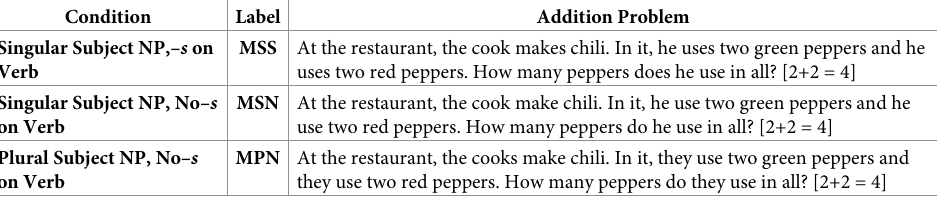
Table 9. Example auditory stimuli for the mathematical reasoning experiment (addition Problems).